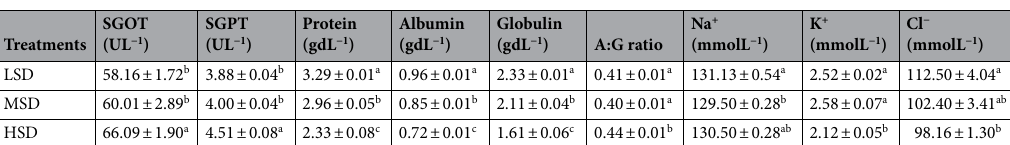
Table 2. Serum biochemical indices of L. rohita stocked at three different stocking densities. Values are mean ± SE. Means in the same column within each classification bearing different superscripts (a, b, c) are significantly different ( P < 0.05). SGOT serum glutamate oxaloacetate transaminase, SGPT serum glutamate pyruvate transaminase, A:G ratio albumin:globulin ratio, LSD low stocking density, MSD medium stocking density, HSD high stocking